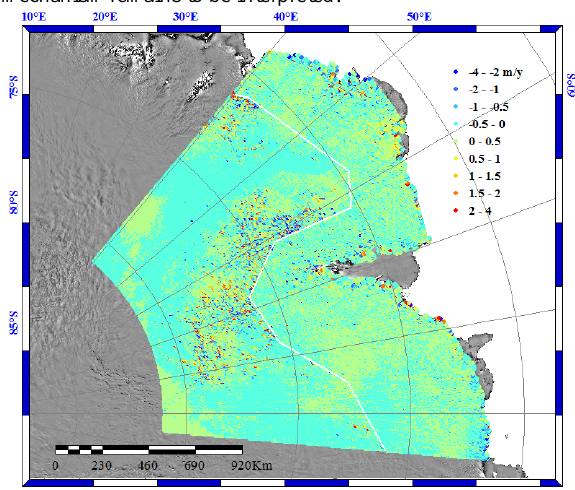
Figure 3. Spatial distribution of elevation change rate of 5 × 5 km boxes in LAS derived from CryoSat-2